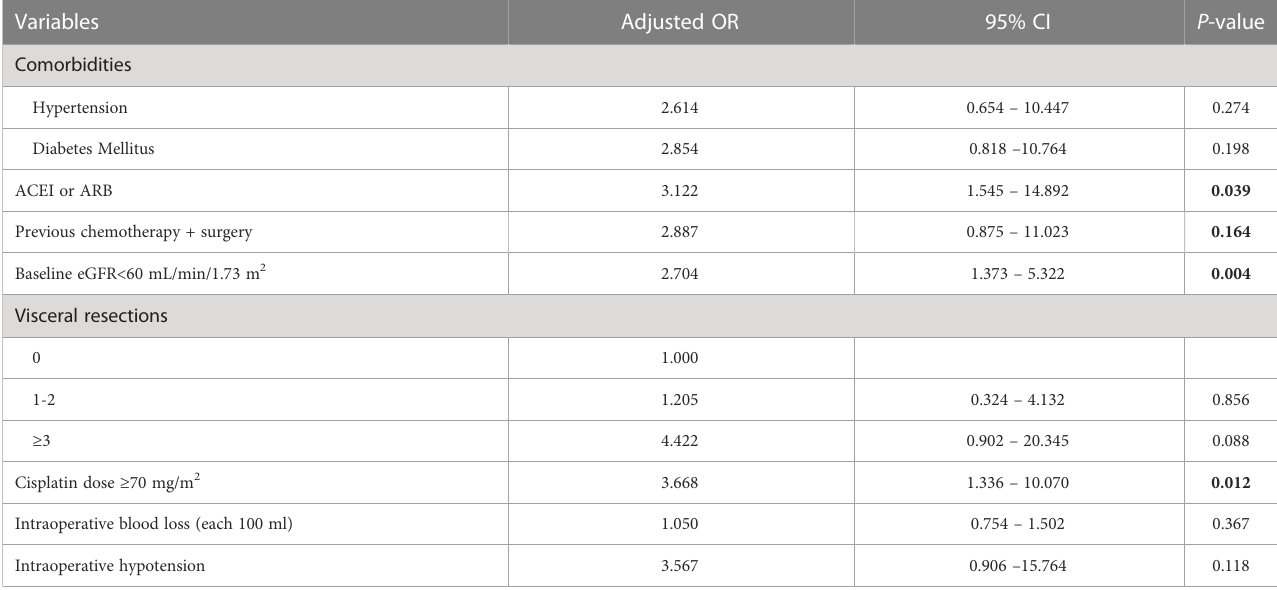
TABLE 3 Multivariate analysis of risk factors for AKI after CRS plus HIPEC.